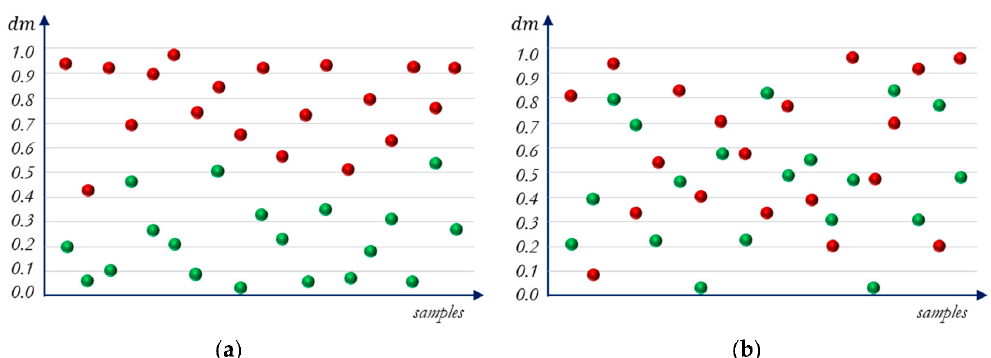
Figure 3. Scheme of the distribution of MOT ( a ) and Re-Id ( b ) samples representations in the metric distance space. Points in green render the distance resulting of comparing a positive pair of images, and points in red, a negative pair.